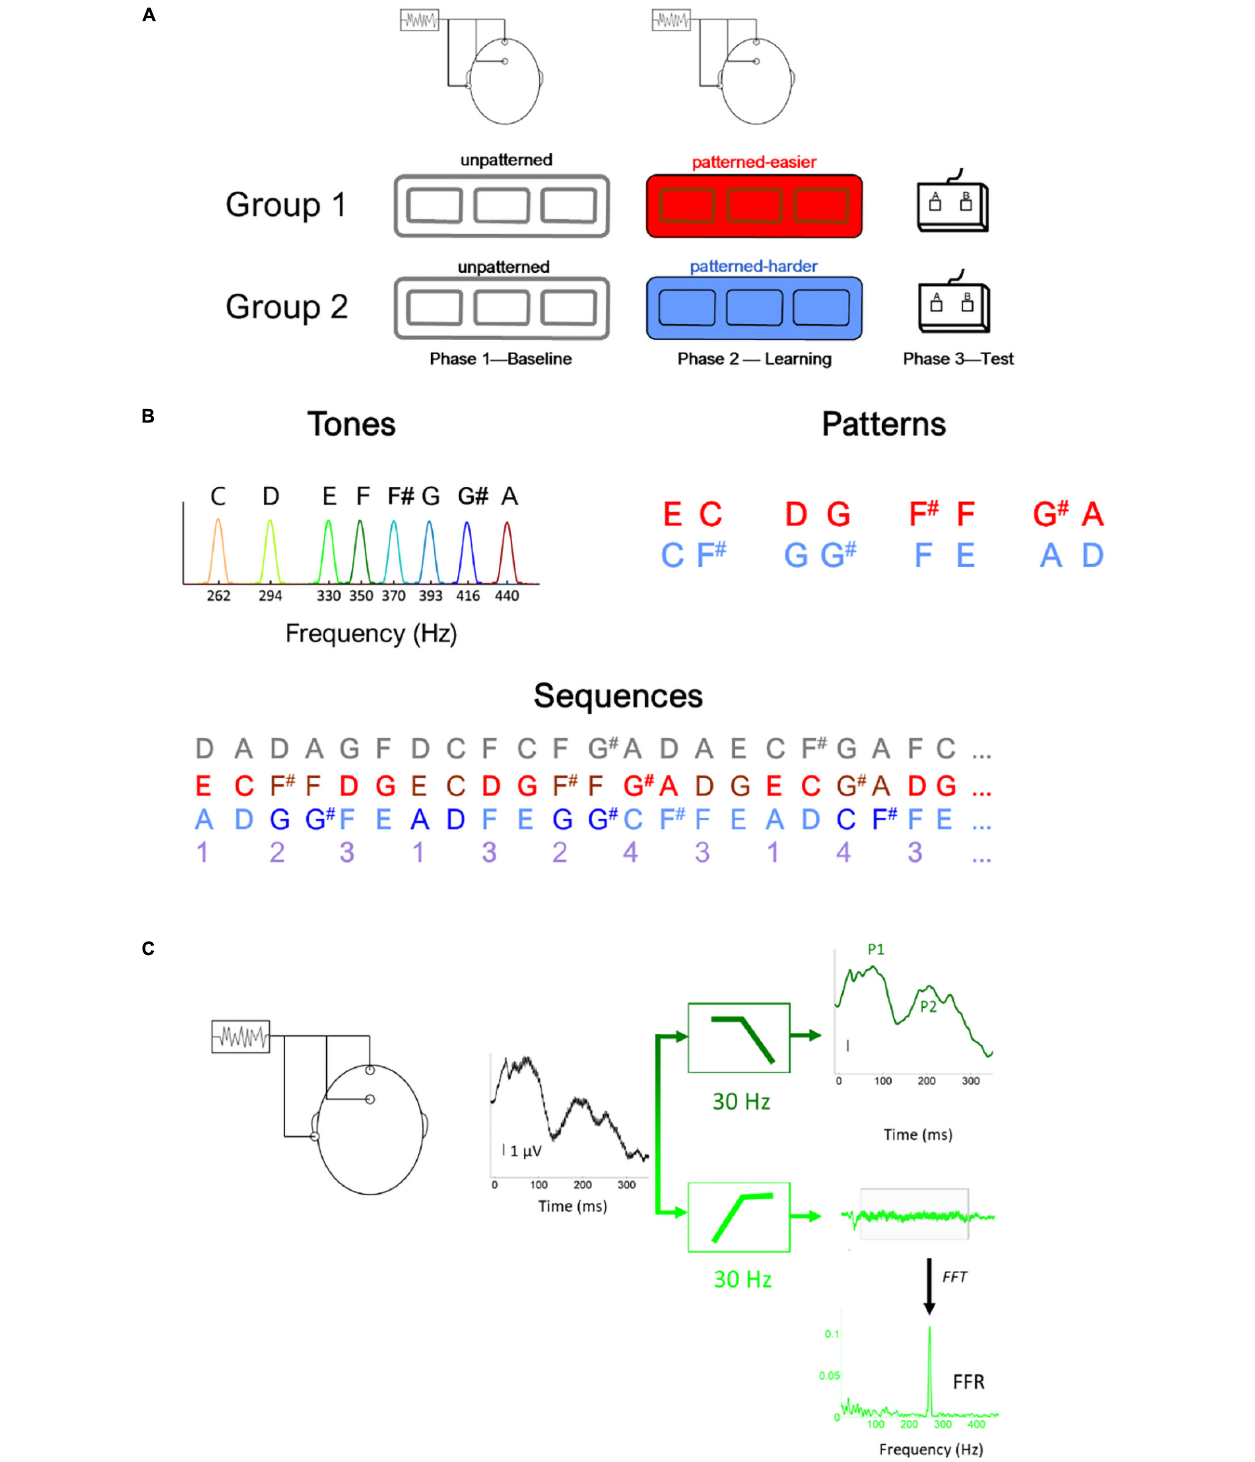
FIGURE 1 | Illustration of (A) experimental design, (B) stimulus (i.e., tones) and sequence characteristics, (C) filtering procedure to derive the brainstem (light green) and cortical (dark green) potentials, illustrated using the response to the lowest tone (262 Hz) (C) . In panel (B) , the gray numbers illustrated the unpatterned sequence and the purple numbers illustrate the generating sequence used to construct both the easier (red) and harder (blue) sequences. Using this generating sequence, 1 was replaced with EC for the easier sequence and AD for the harder sequence and 2 was replaced with F#F in the easier sequence and GG# in the harder sequence, etc. Thus, in addition to being composed of tones with the same fundamental frequencies and the same interstimulus interval between tones, the generating structure of the two pattern sequences had the same transitional probability distribution.